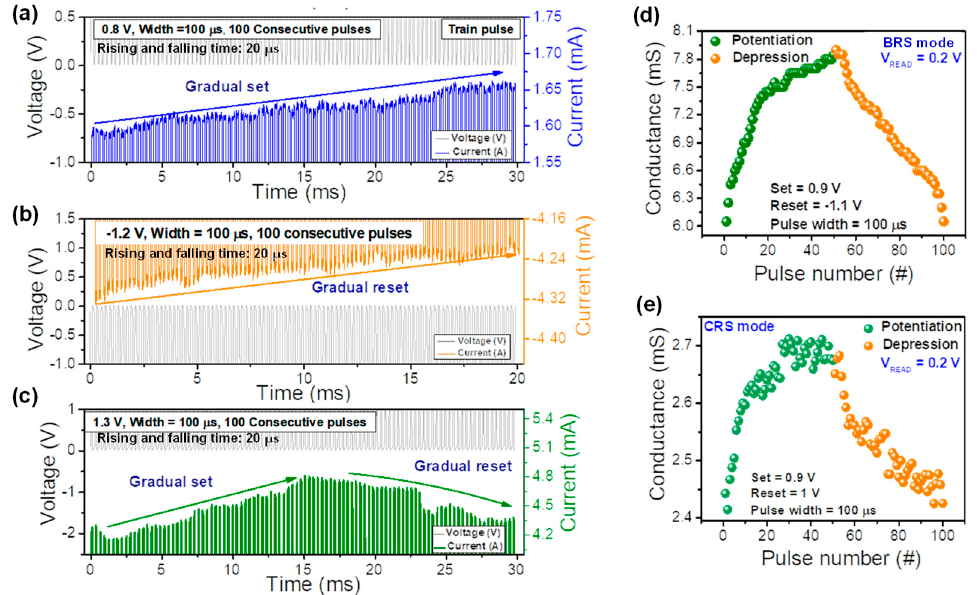
Figure 4. Synaptic plasticity of the Pt/ZnO/TiN device. Pulse train of ( a ) set and ( b ) reset for the BRS mode and ( c ) set and reset for the CRS mode; potentiation and depression of ( d ) the BRS mode and ( e ) the CRS mode.